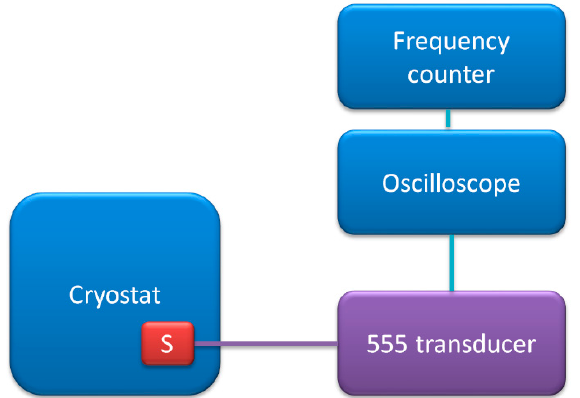
Figure 7. Schematic diagram of measurement test stand for resistive temperature sensor calibration.